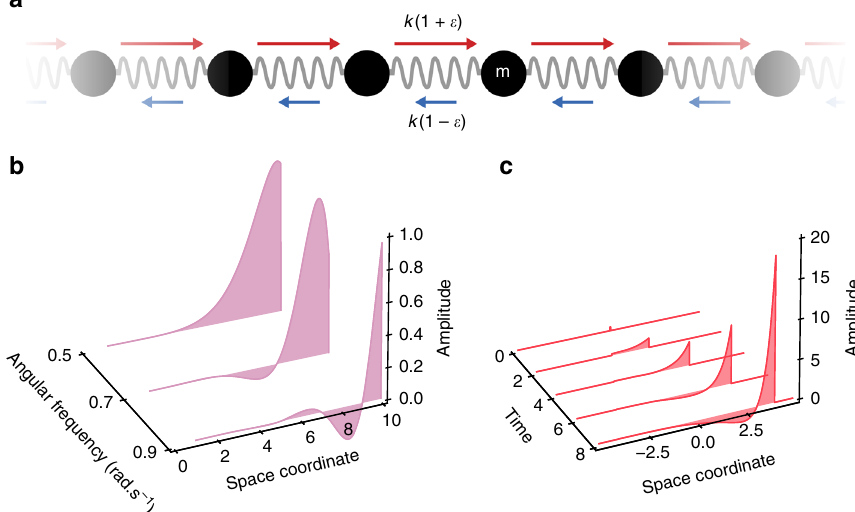
Fig. 1 Asymmetric and unidirectionally ampli fi ed waves in a nonreciprocal mass-and-spring model. a Schematic representation of the nonreciprocal mass- and-spring model. b Magnitude of the solutions of Eq. (1) in the frequency domain exp( i ( ω t − q ± x )) vs. spatial coordinate, for three different frequencies. c Green ’ s function of Eq. (1) vs. time and spatial coordinate. In ( b ) and ( c ), ε = 0.9 and c =